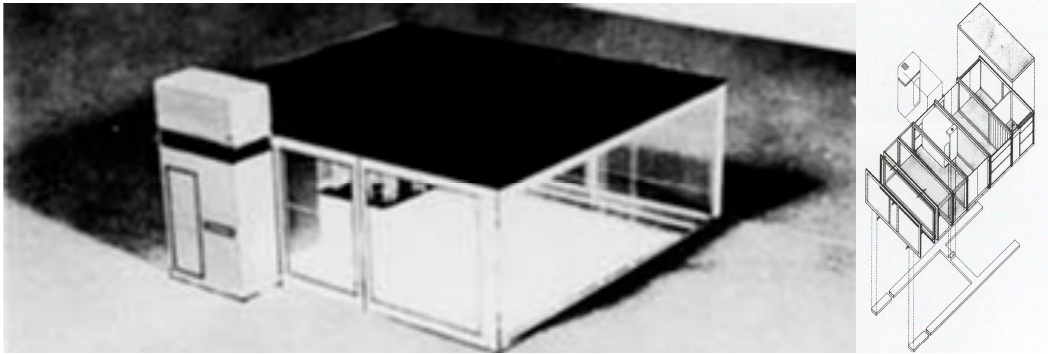
Figure 5. Steel Housing by Cedric Price, 1967: simple model, structure and connections [11].